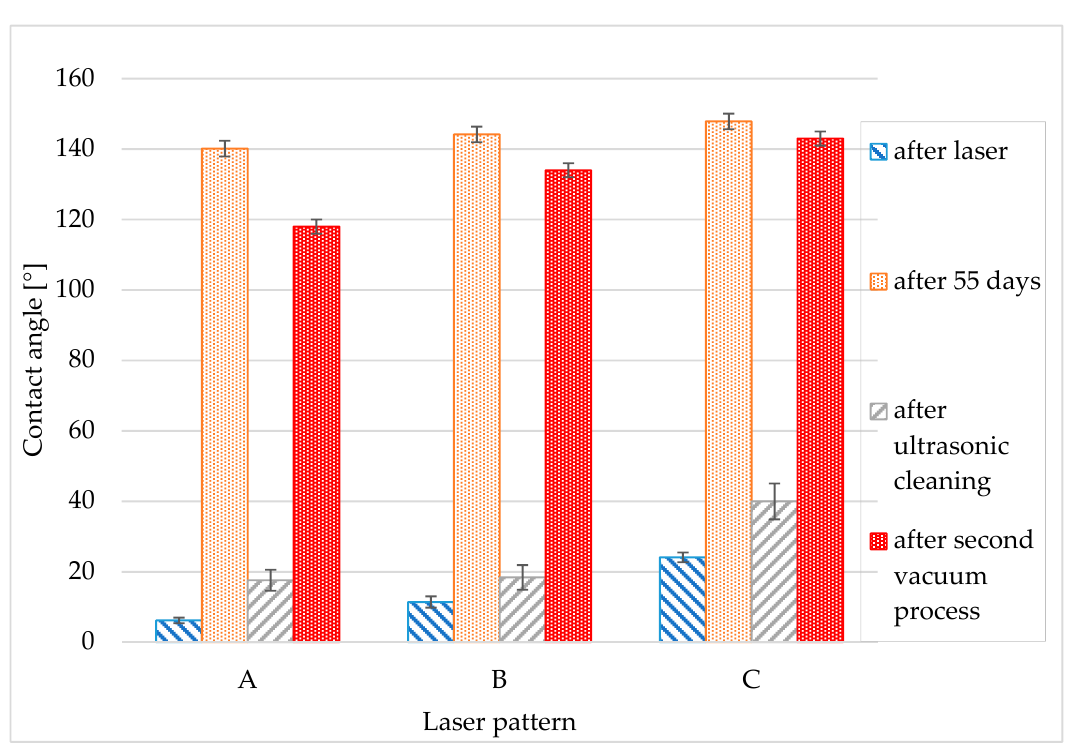
Figure 8. The quick transition between hydrophilic and hydrophobic states after the vacuum process and ultrasonic cleaning for three different laser structures A, B, C.